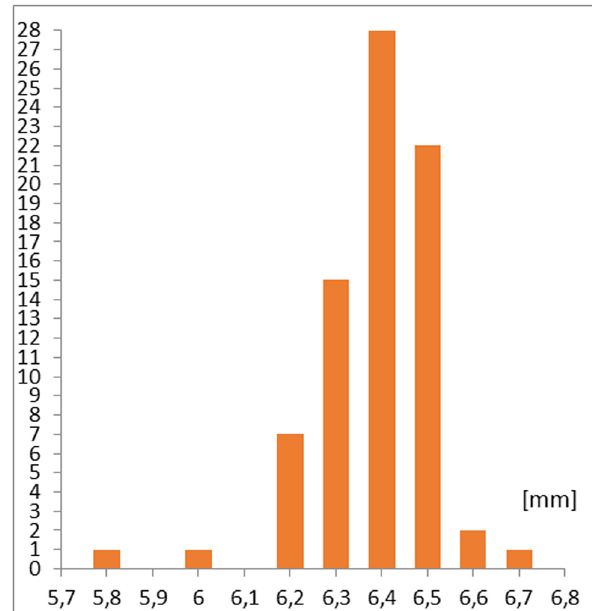
Figure 12: Histogram of random variation in thickness of corroded sheets obtained for the fi rst coating sheet of the tank number 4. The measurements were taken in 2001. Mean value ( estimated from the sample ) 6.39 mm, standard deviation 0.13 mm, coe ffi cient of varia - tion 0.021.